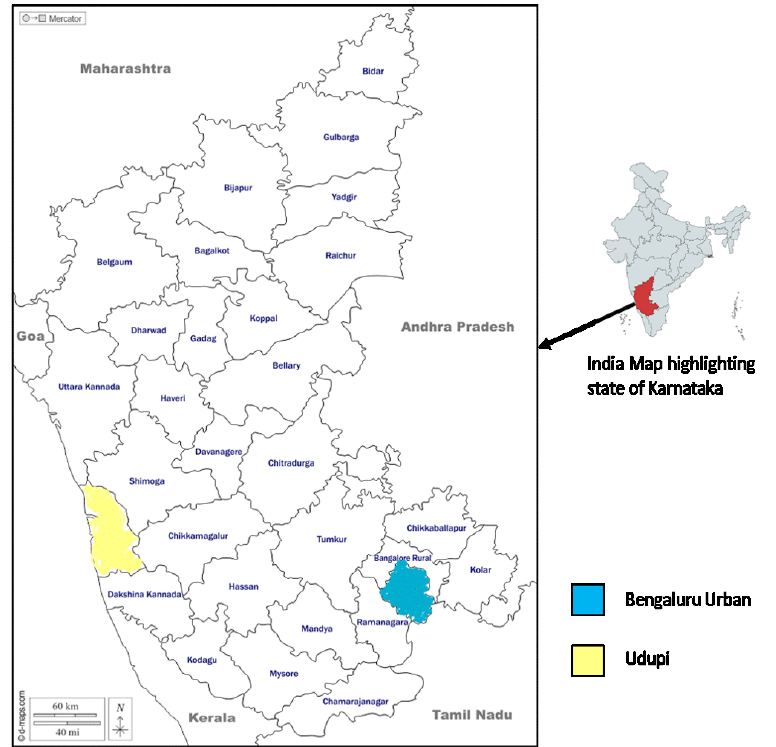
Figure 1. The highlighted areas are the selected study sites i.e., Bengaluru urban and Udupi districts in Karnataka.